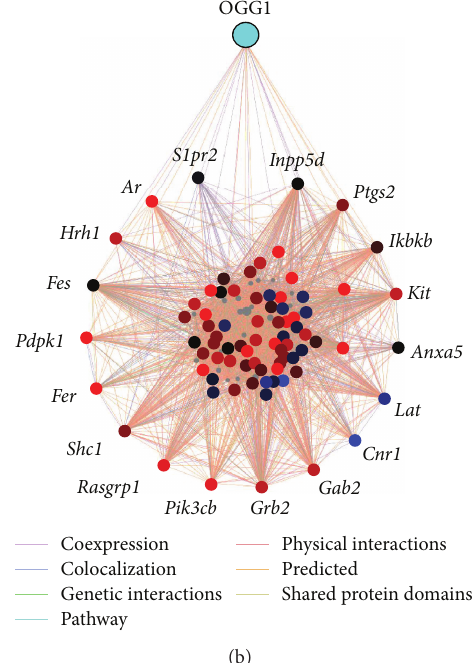
Figure 2: OGG1-BER induced gene expression associated to airway mast cell degranulation. Mouse lungs received a single challenge (SC) or multiple challenges (MC) with 8-oxoG. Lungs were collected at 30 and 60 min after challenge and analyzed at whole- transcriptome level by RNA-Seq. (a) Hierarchically clustered heat map was generated using GENE-E online software (Broad Institute, http://www.broadinstitute.org/) considering transcript levels (fold-change). Red represents upregulation and blue represents downregulation. (b)EnrichmentinteractionnetworkoftheknownandpredictedinteractionsamongthesetassociatedwithmastcelldegranulationandOGG1. Peripheral nodes represent genes with a direct interaction with OGG1. The modified network was generated with GeneMania online database